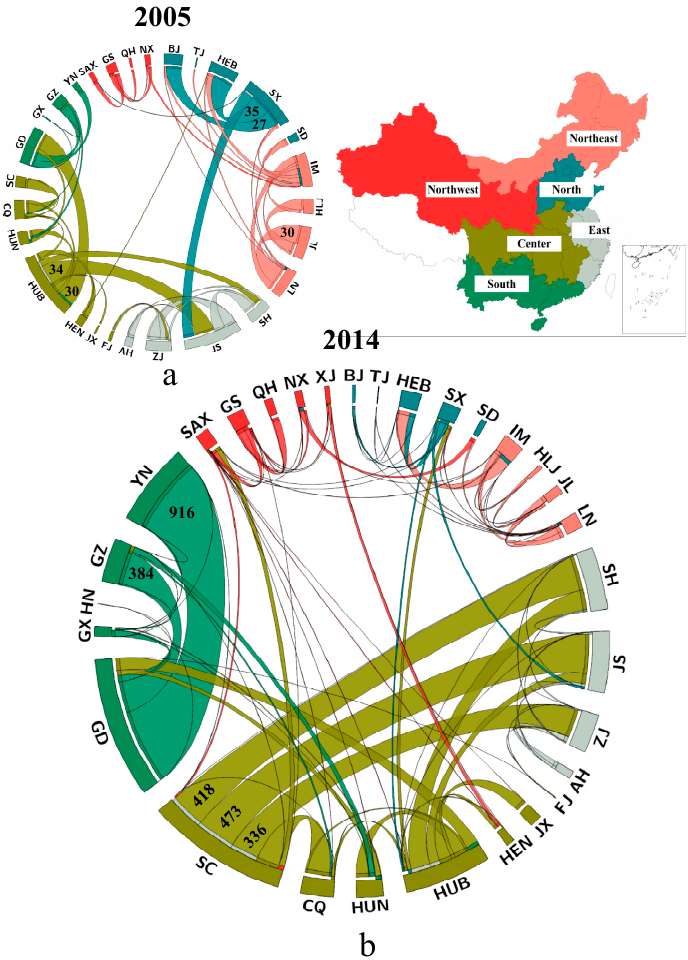
Figure 2. Pair-wise virtual water flows between provinces in 2005 ( a ), and 2014 ( b ). The top five flows are labeled. The color of the ribbon represents the different subnational grid. The ribbon touches inner circle refers to the export, while out of touch means an import. AH—Anhui, BJ—Beijing,